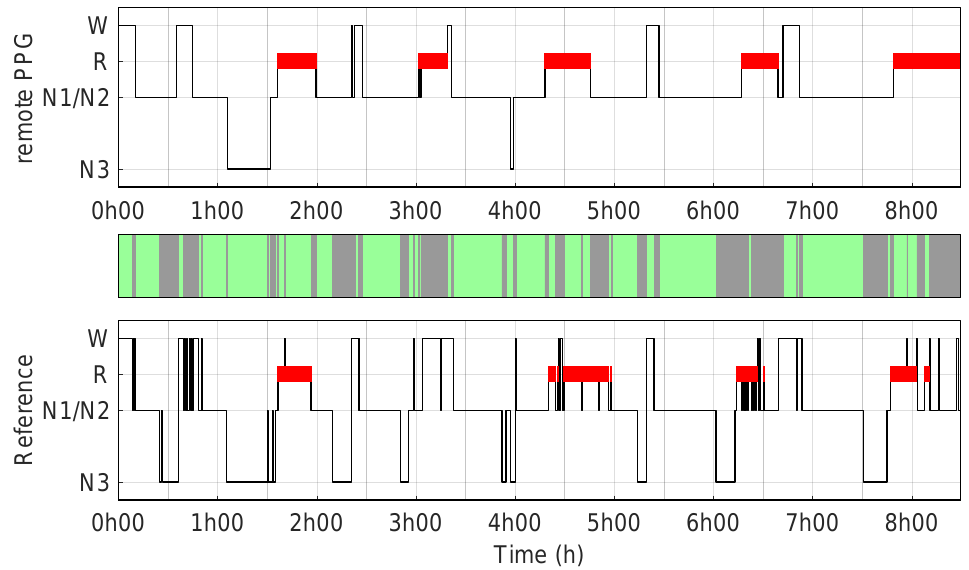
Figure 3. Hypnogram for an average performance of remote PPG setup. Hypnograms for one example recording of a participant for which the predictions of the remote PPG setup compared to PSG manual scoring has κ remotePPG closest to the average performance (accuracy 67%, κ = 0.46); ( top ) Hypnogram predictions using remote PPG; ( bottom ) reference hypnogram based on PSG manual